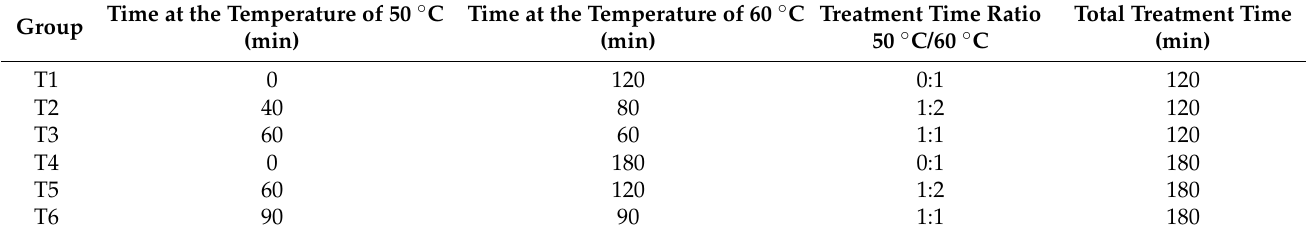
Table 1. Sous vide treatments applied to chicken